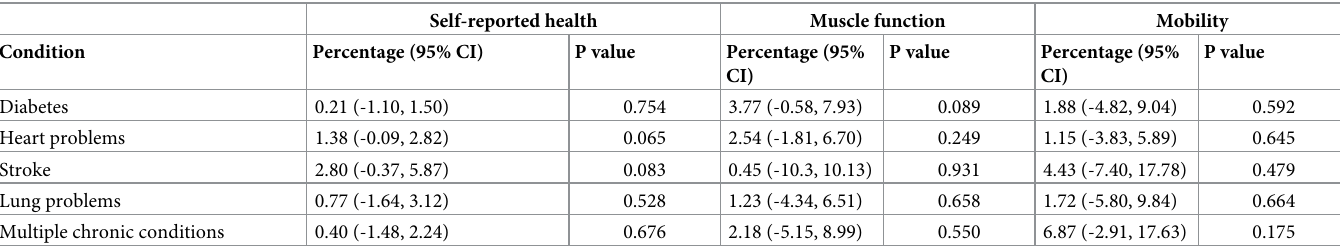
Table 3. Percentage decreases in scores of self-reported health, large muscle function, and mobility by chronic diseases per wave after disease incidence.